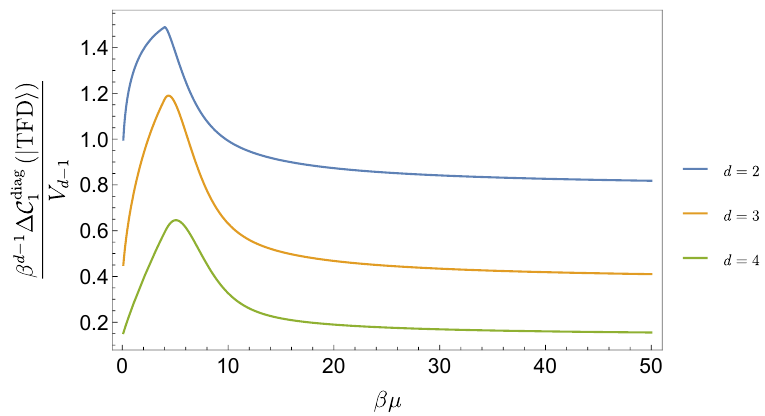
Figure 12 . The integrated mutual complexity in the diagonal basis, i.e. (cid:1) C diag eq. (4.36) for a massless (cid:12)eld theory in di(cid:11)erent